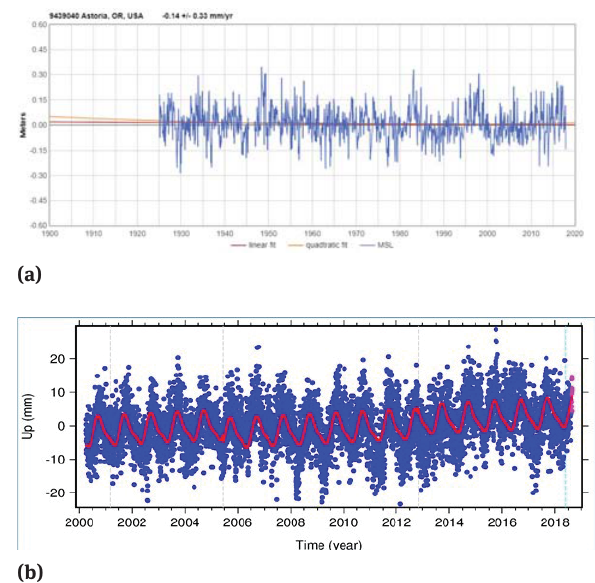
Figure 15: (a) MSL data for Astoria, OR, USA. Image reproduced modified after [4]. (b) GNSS time series for TPW2. Image reproduced modified after NGL. This GNSS antenna is almost co-located with the tide